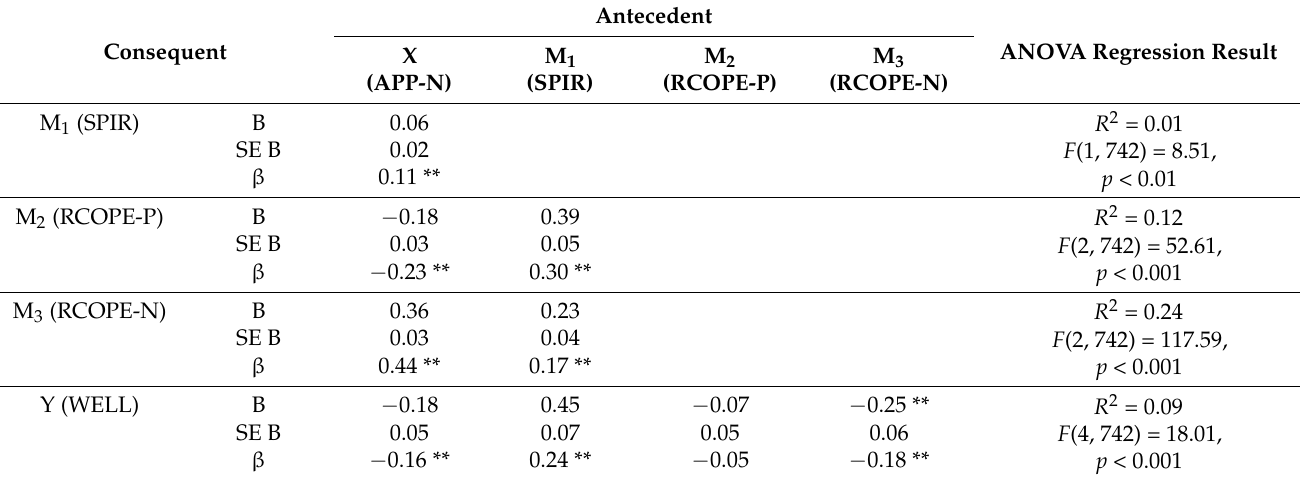
Table 3. Model coefficients for the mediation model with serial and parallel mediation properties.